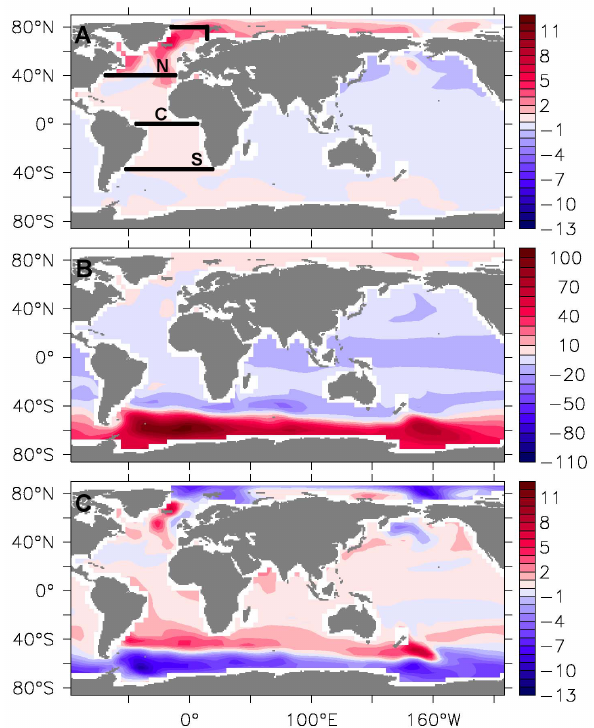
Fig. 2. Dynamic sea level rise in cmSv − 1 (i.e. normalized to a weakening of the AMOC by 1Sv), after 100yr of the following forcings: (A) freshwater with a target value of 0.064Sv, (B) South- ern Ocean winds approaching zero, (C) CO 2 with a target concen- tration of